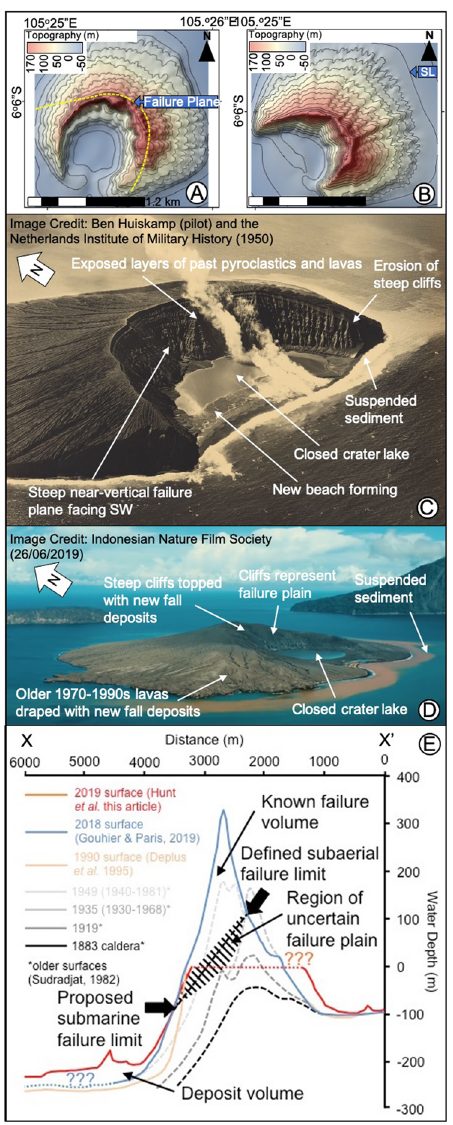
Fig. 2 Evidence of past fl ank failures at Anak Krakatau and the in fl uence of landsliding on the submarine slopes. A Pre-collapse topographic contour map (10 m contours) of Anak Krakatau in 1941 (based upon Seibold & Seibold, 1996). The 1941 pre-collapse topography is overlain by the projected 1949 failure plane based upon the cliff top of the post-collapse island topography (Fig. 9B) and 1950 aerial photographs (Fig. 9C). B Topographic contour map (10 m contours) of Anak Krakatau in 1950 (based upon Decker and Hadikusumo, 1960). C Aerial photograph of Anak Krakatau taken in 1950 following a May 1949 collapse of the SW fl ank (Image credit: Militaire Luchtvaart and Royal Netherlands Air Force (1950) provided courtesy of pilot Ben Huiskamp); D Aerial still-image taken from drone footage of Anak Kraktau on 26/05/2019 after the 2018 fl ank collapse (Image credit: Indonesian Nature Film Society). The fi gure shows the similar failure geometry between collapses in 2018 and 1949, and the similar post-collapse recoveries. E Slope pro fi les of the SW fl ank of Anak Krakatau comparing our proposed shallow failure scenario with new 2019 post-collapse bathymetry, pre-collapse 1990 bathymetry and older slope pro fi les. These pro fi les show the recession in the slope at a water depth of − 100 to − 120 m resulting from the 2018 fl ank collapse. Failure aligns to the position of the position of the past Anak Krakatau tuff ring crater and the scarp of the 1883 caldera margin; suggesting the pre-existing caldera wall may provide a structure to in fl uence fl ank